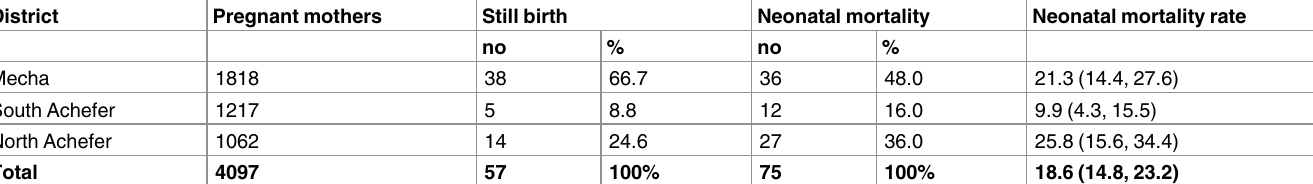
Table 2. Neonatal mortality rate across selected districts of West Gojam zone, Feb 2012. District